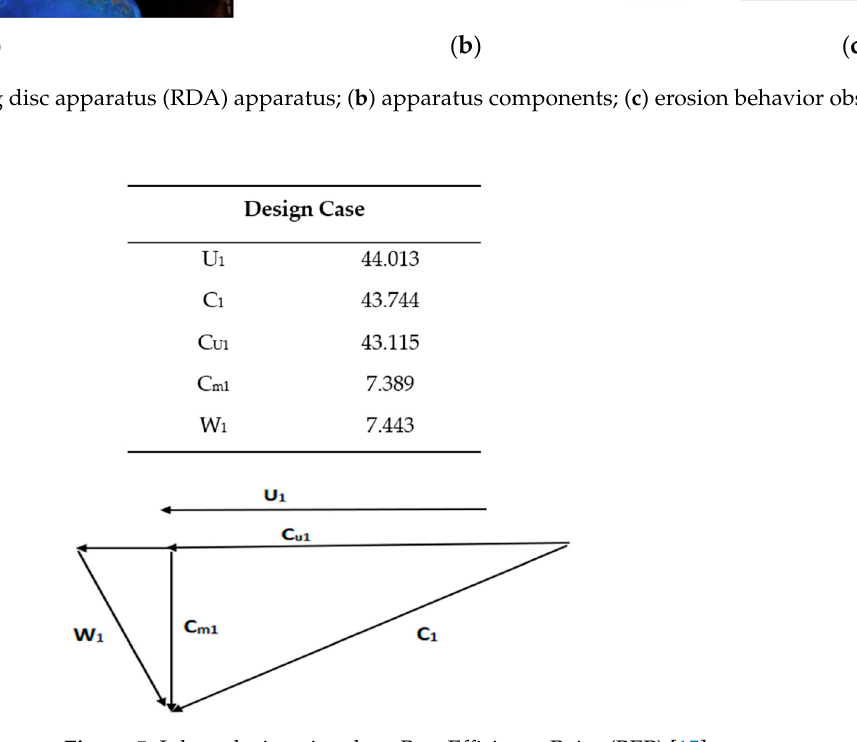
Figure 5. Inlet velocity triangle at Best Efficiency Point (BEP)